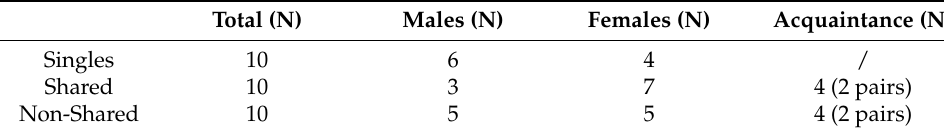
Table 1. Overall descriptive data of the participants.